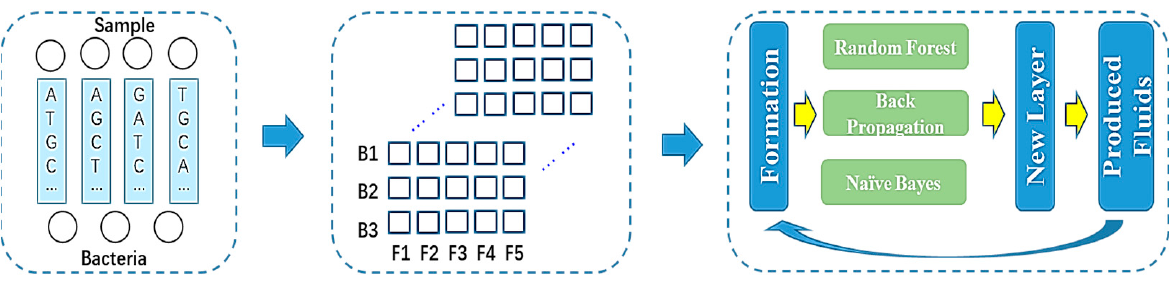
Figure 6. Sample data interpretation and clustering model. The establishment of the formation traceability model of the production fluid first requires converting the DNA sequencing results of the samples into a matrix, where each column represents a layer and each row represents a formation feature. A new layer is obtained by clustering the sample data by three methods: random forest, back propagation, and Naive Bayes. After that, the formations contained in the yield sequencing results are clustered as features to sub-trace the probability of originating from each formation. The specific analysis process is shown below.